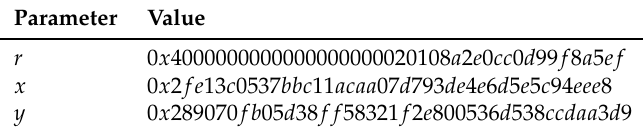
Table 2. Parameters for the Basic Elliptic Curve Operations.